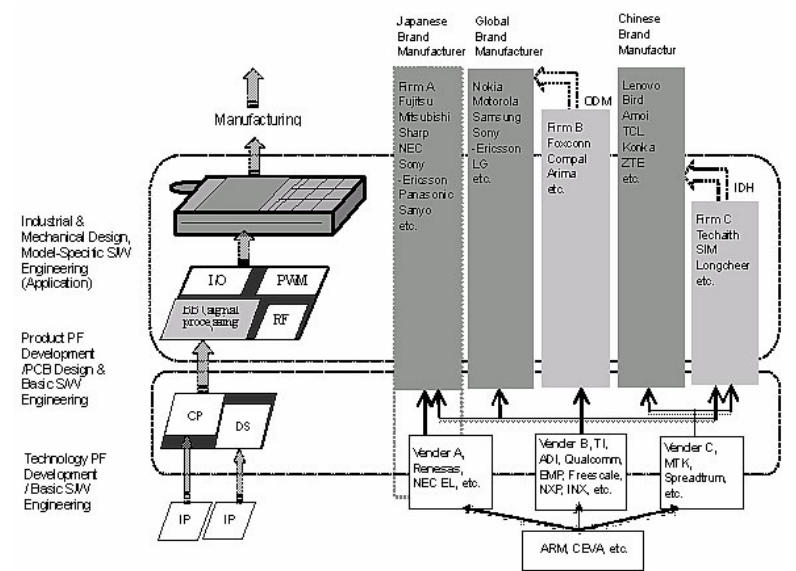
Figure 3 . Modularity of mobile phone handset development